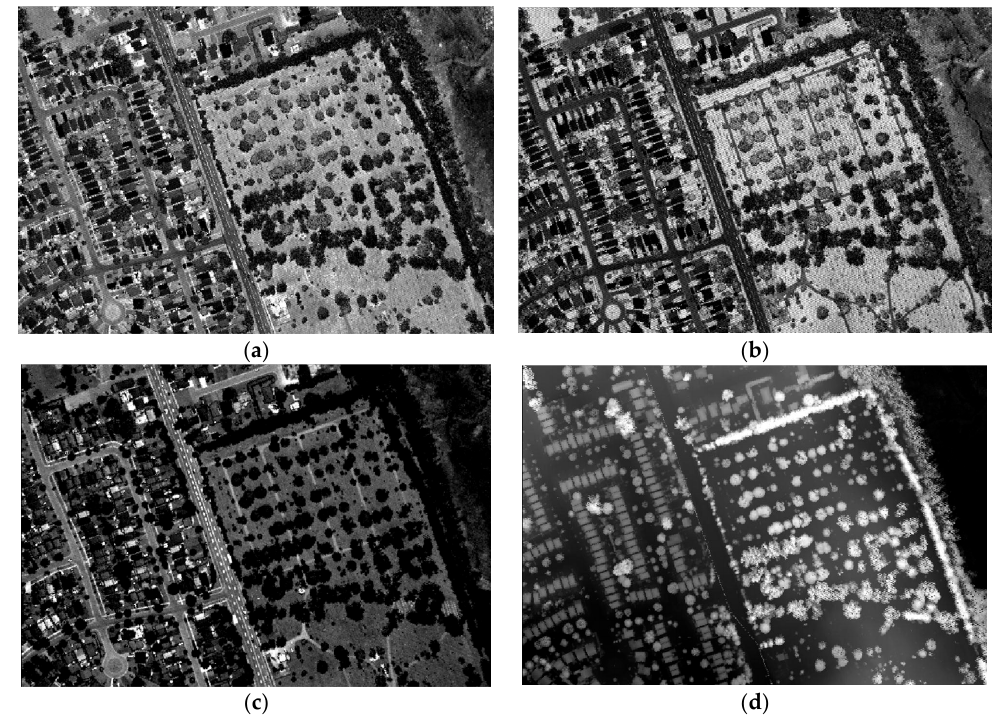
Figure 6. LiDAR raster images: ( a ) C1 intensity; ( b ) C2 intensity; ( c ) C3 intensity; ( d ) DSM.